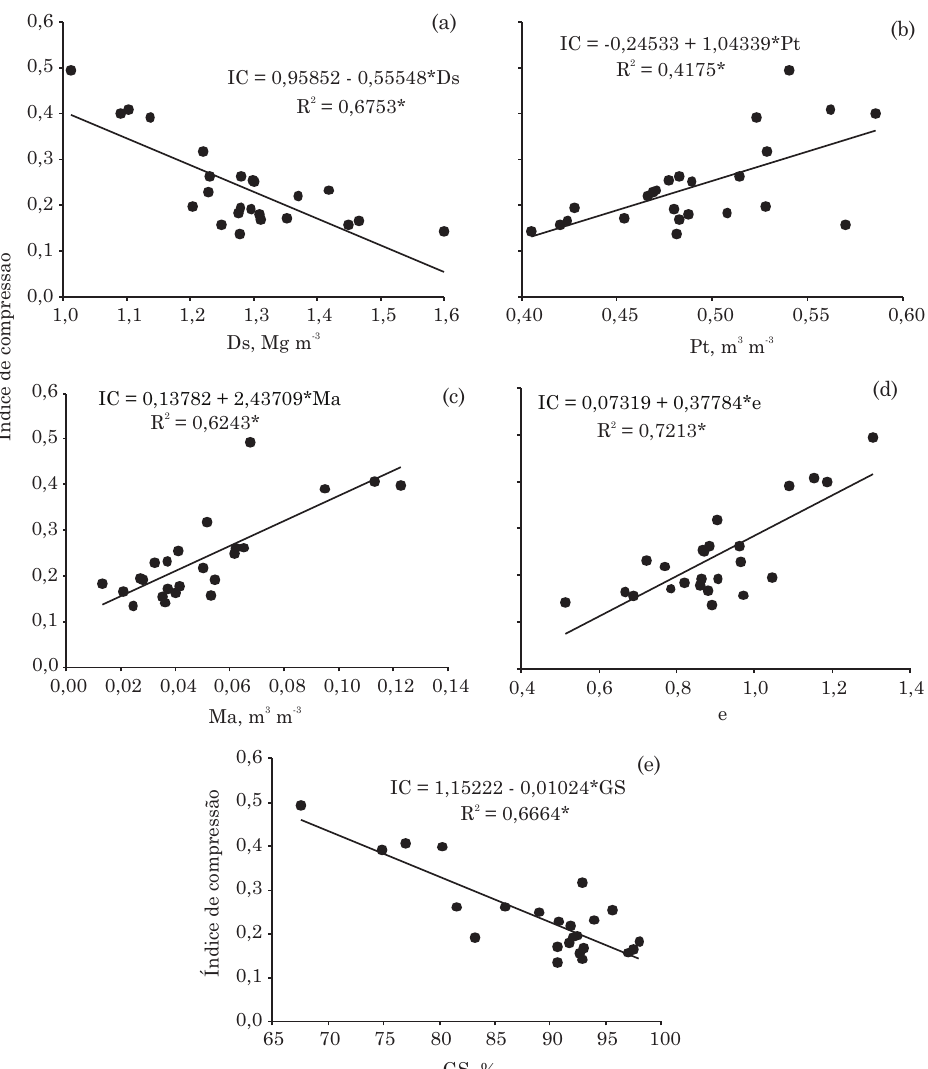
Figura 1. (a) Regressão linear do índice de compressão (IC) em razão da densidade do solo (Ds), (b) porosidade total (Pt), (c) macroporosidade (Ma), (d) índice de vazios ( e ) e (e) grau de saturação (GS) para o Gleissolo Háplico. ** e * significativo a 5 e 1 %, respectivamente. N =